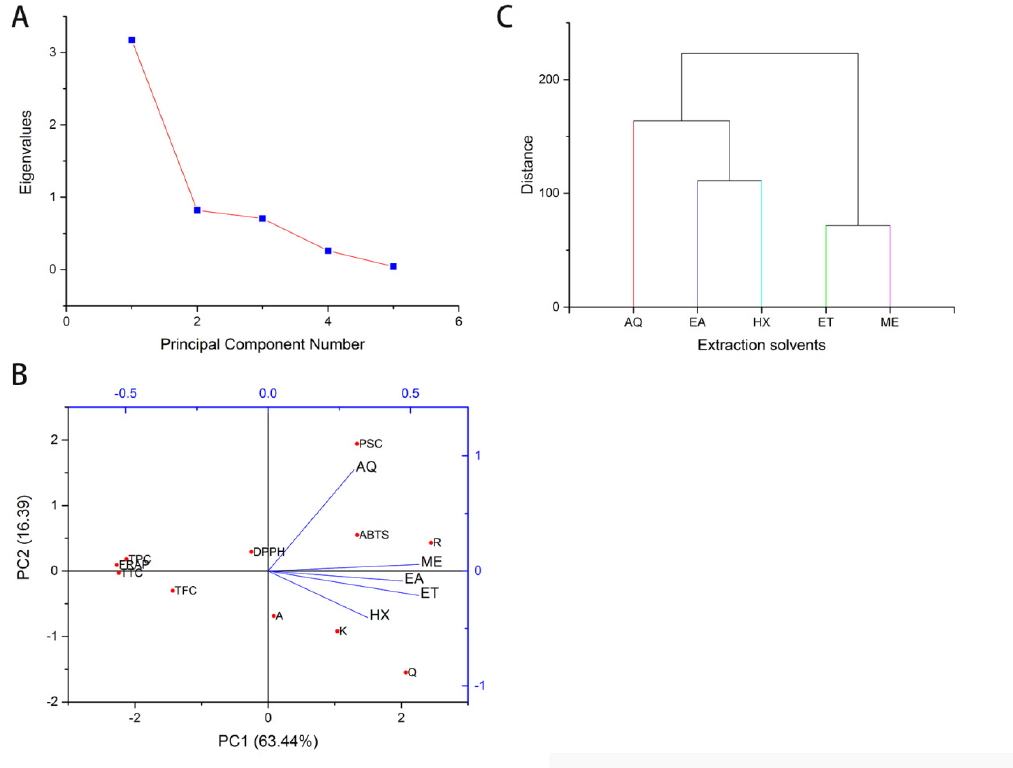
Figure 4. Principal component analysis and hierarchical cluster analysis of the various extracts, constituents, and bioactivities. ( A ) Eigenvalues of the variances. ( B ). Contribution of bioactive constituents to the principal components 1 and 2. ( C ). Dendogram of cluster analysis. FRAP: Ferric Reducing Antioxidant Potential; DPPH: 2,2-Diphenyl-1-picrylhydrazyl; ABTS: 2,2 ′ -azino-bis (3- ethylbenzothiazoline-6-sulfonic acid (%); AQ: Water; ET: Ethanol; EA: Ethyl acetate, HX: n-Hexane; ME: Methanol; A: apigenin; R: rutin; Q: quercetin; K: kaempferol.